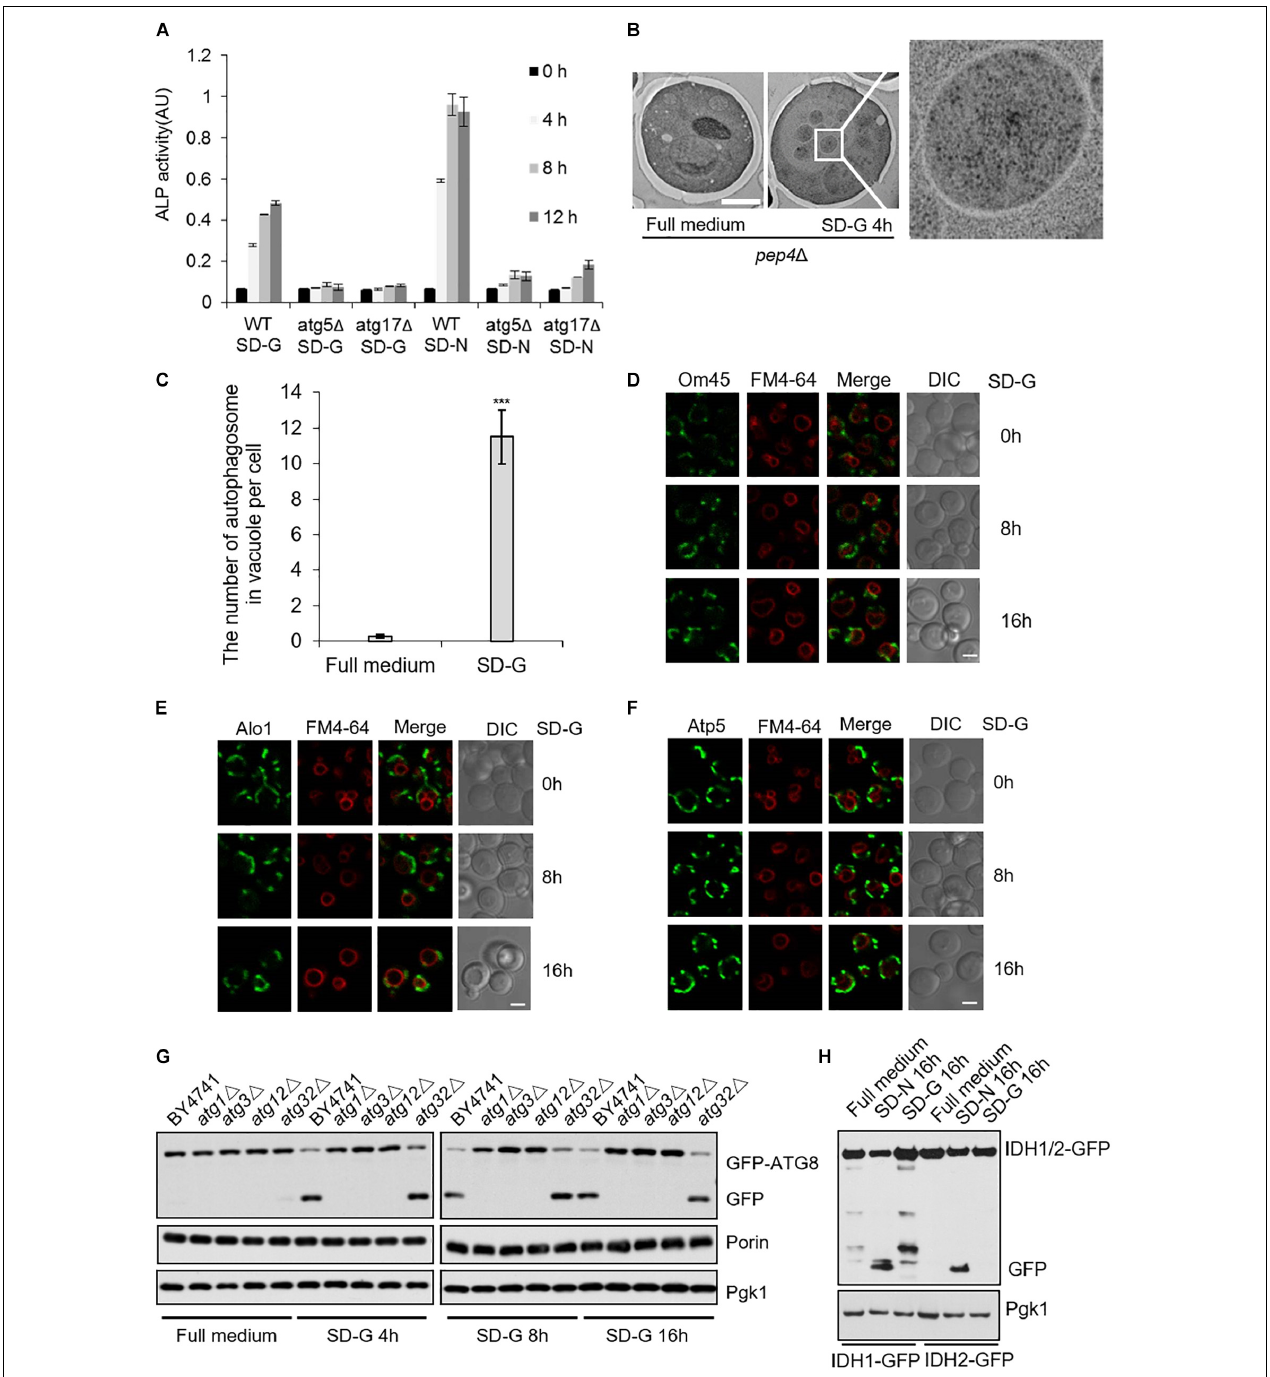
FIGURE 5 | Glucose starvation doesn’t induce mitophagy. (A) ALP assay for autophagic activity. In wild type, atg5 (cid:49) , and atg17 (cid:49) cells, ALP activity was tested at the indicated time points under SD-G or SD-N conditions from n = 3 independent experiments. Error bars indicate standard deviation (SD). (B) EM analysis of autophagy in pep4 (cid:49) cells grown in full medium or SD-G. Scale bar, 2 µ m. (C) 50 cells from (B) were analyzed for the number of autophagosomes inside the vacuole per cell from n = 3 independent experiments. Error bars indicate standard deviation (SD). *** p < 0.001; two-tailed Student’s t -tests were used. (D–F) Cells expressing the GFP-tagged mitochondrial proteins Om45, Alo1, and Atp5 were glucose starved for 0, 8, and 16 h. Cells were viewed by laser confocal microscopy. Scale bar, 2 µ m. FM4-64 is a vacuole membrane dye. (G) Wild type (BY4741), atg1 (cid:49) , atg3 (cid:49) , atg12 (cid:49) and atg32 (cid:49) cells expressing GFP-Atg8 were harvested at time point 0 (grown in full medium) and after 4, 8, and 16 h of glucose starvation. The cleavage of GFP-Atg8 and the status of Porin and Pgk1 were measured by western blot using the indicated antibodies. (H) Cells expressing the GFP-tagged mitochondrial proteins IDH1 and IDH2 were cultured in SD-G and SD-N for 16 h, respectively, the cleavage of IDH1-GFP and IDH2-GFP were detected by western blot using anti-GFP antibody.